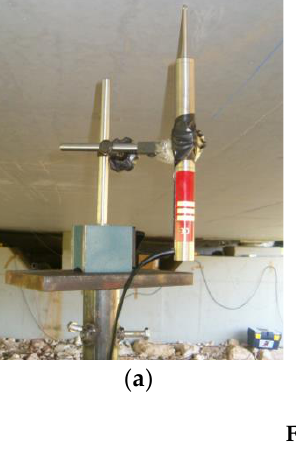
Figure 14. Strain measurement: ( a ) hanger P3; ( b ) rail. The measurement of the accelerations in the train was carried out inside the BAS vehicle, in the position identified in Figure 15. The accelerations were measured using a piezoelectric accelerometer, PCB model 393A03, located in the seat base (point A) and positioned through metallic angles fixed with magnetic discs to the seat frame.